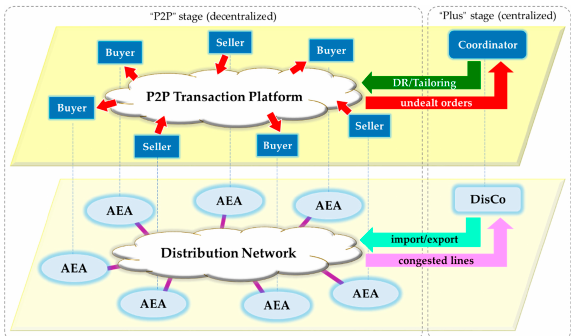
Figure 1. The structure of “P2P Plus” electricity transaction in an AEA community.